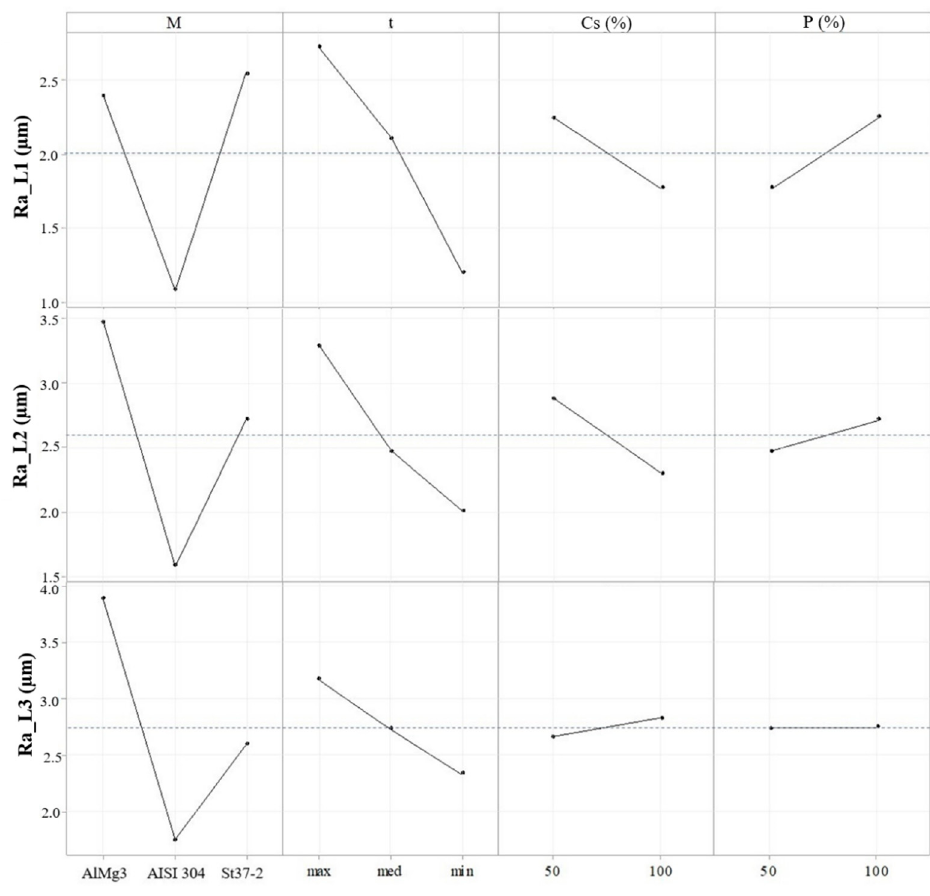
Figure 13. Main e ff ects plot for arithmetic surface roughness (upper, middle and lower Figure 13. Main effects plot for arithmetic surface roughness (upper, middle and lower workpiece workpiece surface). surface).